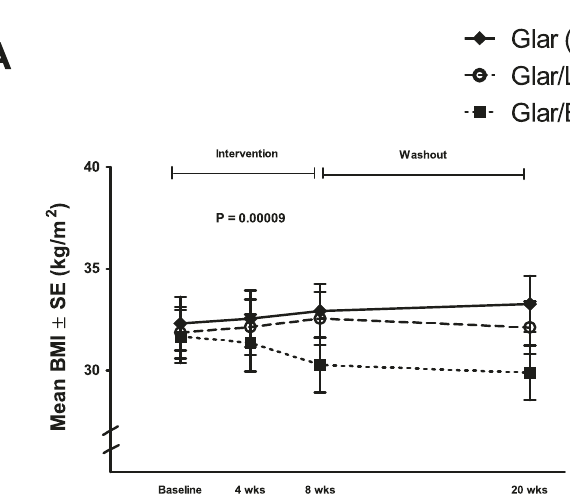
Fig.4|Changesovertimeinanthropometricvariables.A bodymassindex(BMI) and B waist circumference. Data are presented as mean values ± standard error. Generalized estimating equation (GEE) model was used to test time-treatment